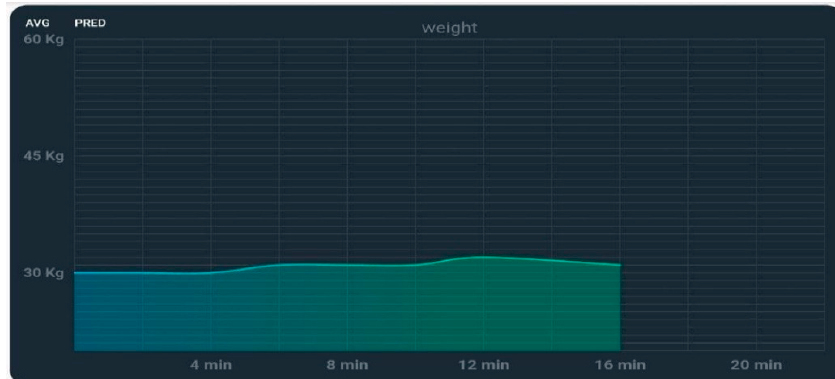
Figure 14. Force measurement from overall sacral region C.